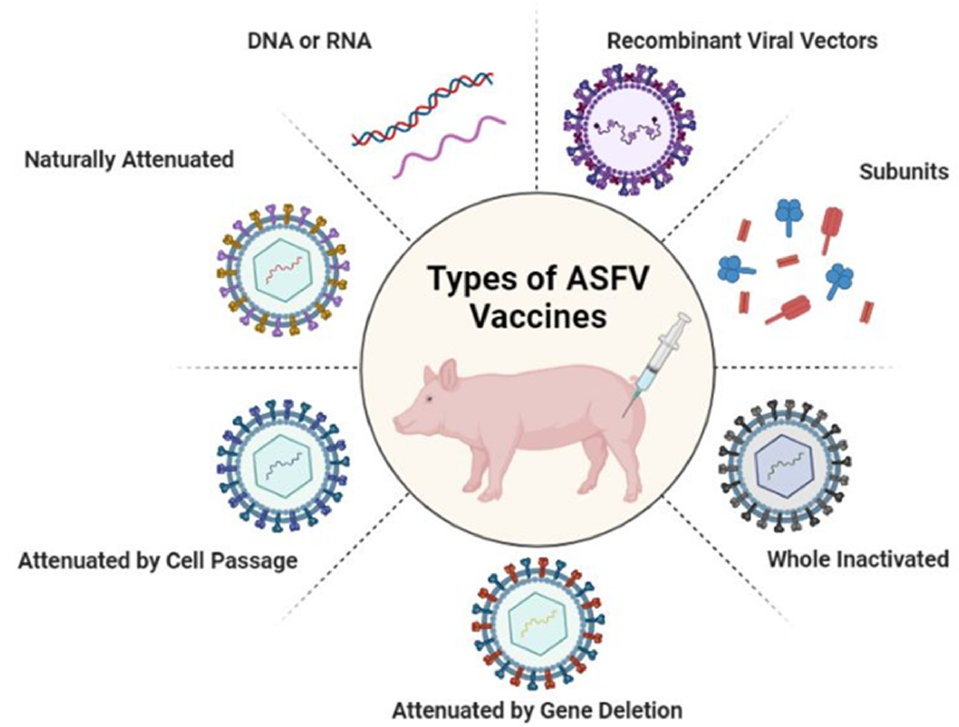
Figure 1. Trends in advances in vaccines against ASFV. Recombinant viral vector vaccines, subunit vaccines, whole inactivated ASF virus vaccines, gene-deleted attenuated vaccines, vaccines attenuated by cell passage, naturally attenuated vaccines and DNA or RNA vaccines. Created with BioRender.com (accessed on 25 December 2022).